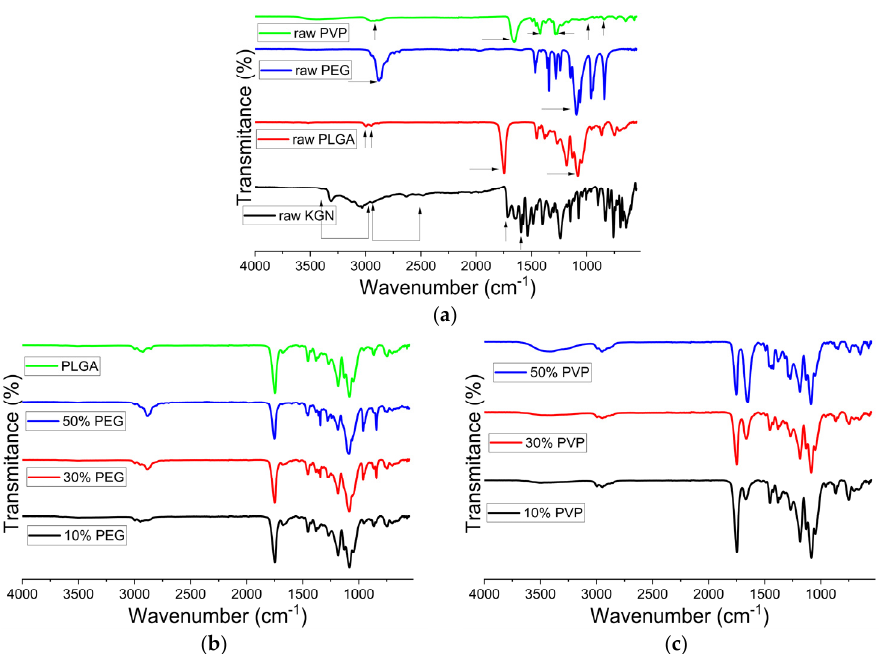
Figure 4. FTIR spectra of ( a ) the raw materials; ( b ) KGN ‐ loaded PLGA and PLGA/PEG particles; and ( c ) KGN ‐ loaded PLGA/PVP particles. The arrows represent the main bands arising in the raw materials.